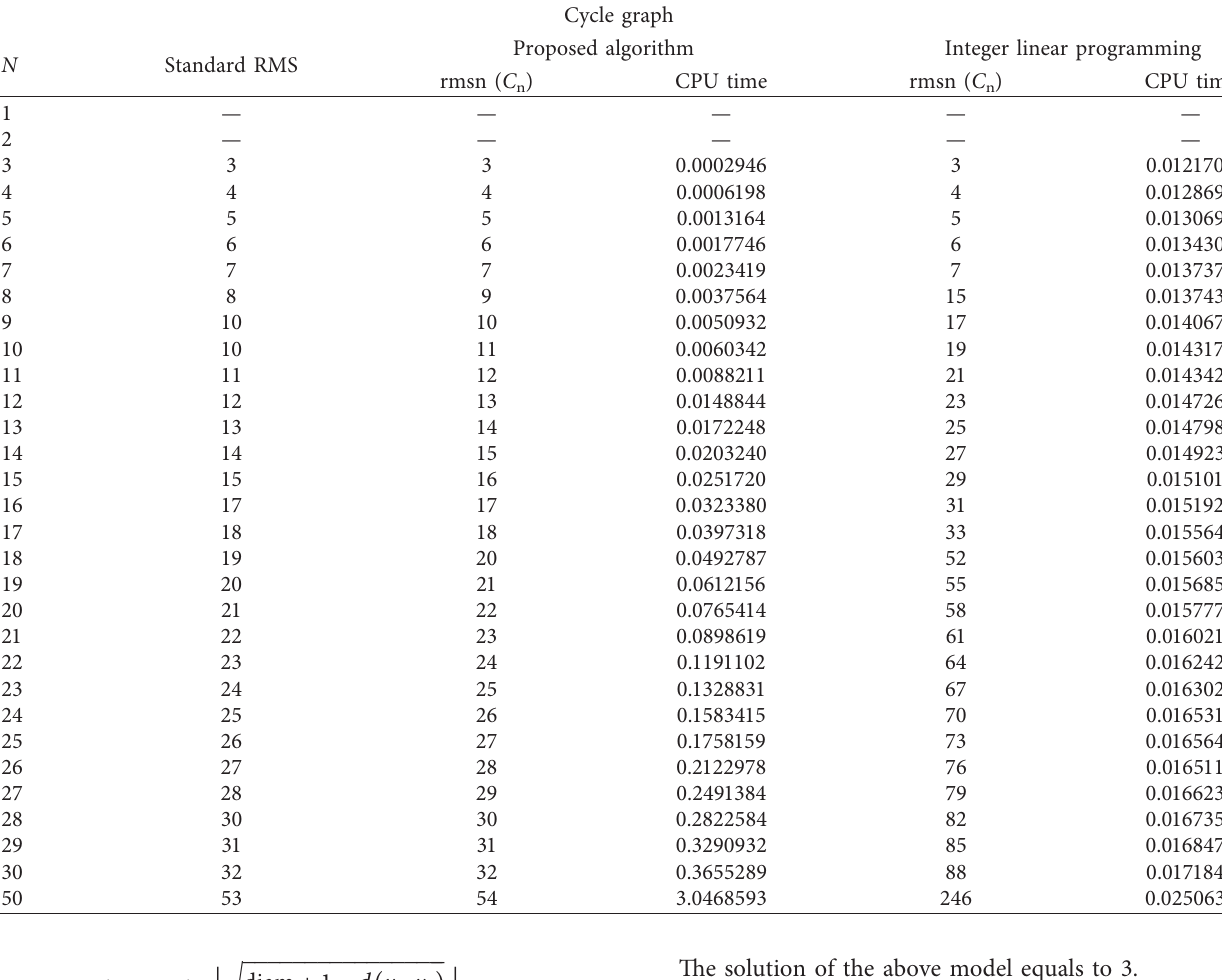
Table 3: Comparison between standard radio mean square number, algorithm, and integer linear programming for the upper bound of radio mean square number for the cycle